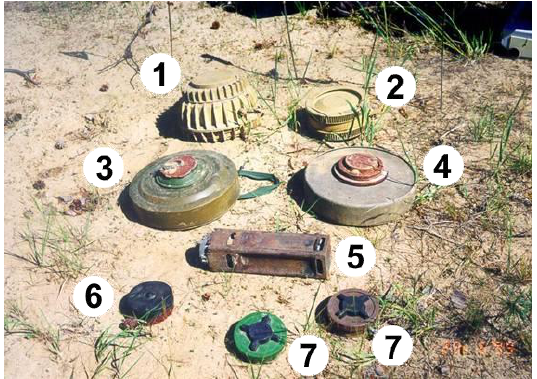
Figure 15. Mines used in experiments: (1) TC-6.1, (2) TC-2.5, (3) TM-62M, (4) TM-62PZ, (5) PTM-3, (6) MS-3, and (7) PMN-2.